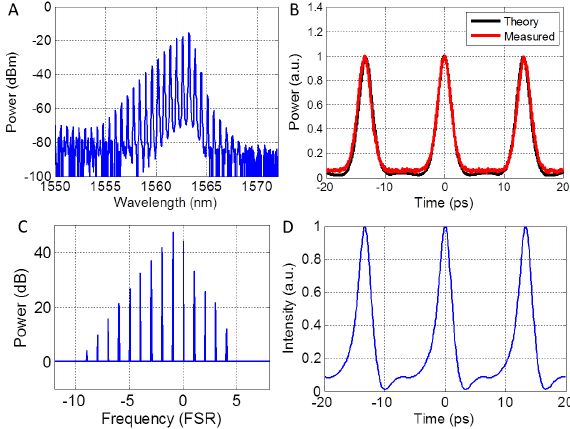
Figure 14: Intracavity waveform of type-I comb. (A) Spectrum of a type-I comb measured at the drop port of a Si 3 N 4 microring. The comb line spacing is ~75 GHz. (B) Autocorrelation trace measured with a dispersion-compensated link and no spectral phase com- pensation. For the calculated result, a flat comb spectral phase is assumed. (C), (D) Simulated comb spectrum and waveform based on estimated experimental parameters. Adapted from Ref. [45]. FSR: free spectral range.